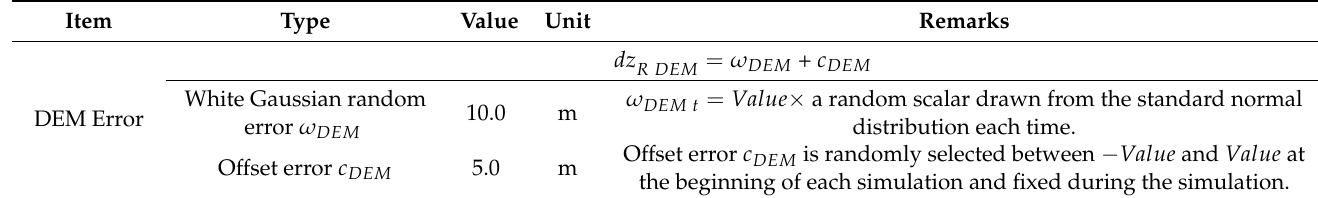
Table 8. Overview of the DEM error used in the simulation.